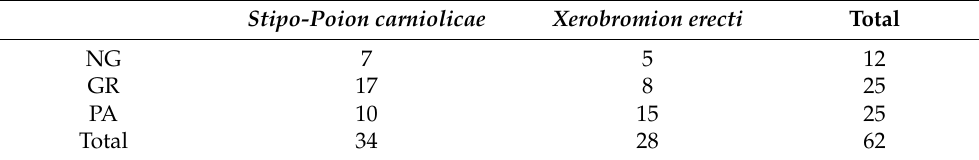
Table 1. Number of permanent transects per grassland type and treatment (NG = not-grazed, GR = grazed, PA = penning areas). Stipo-Poion carniolicae Xerobromion